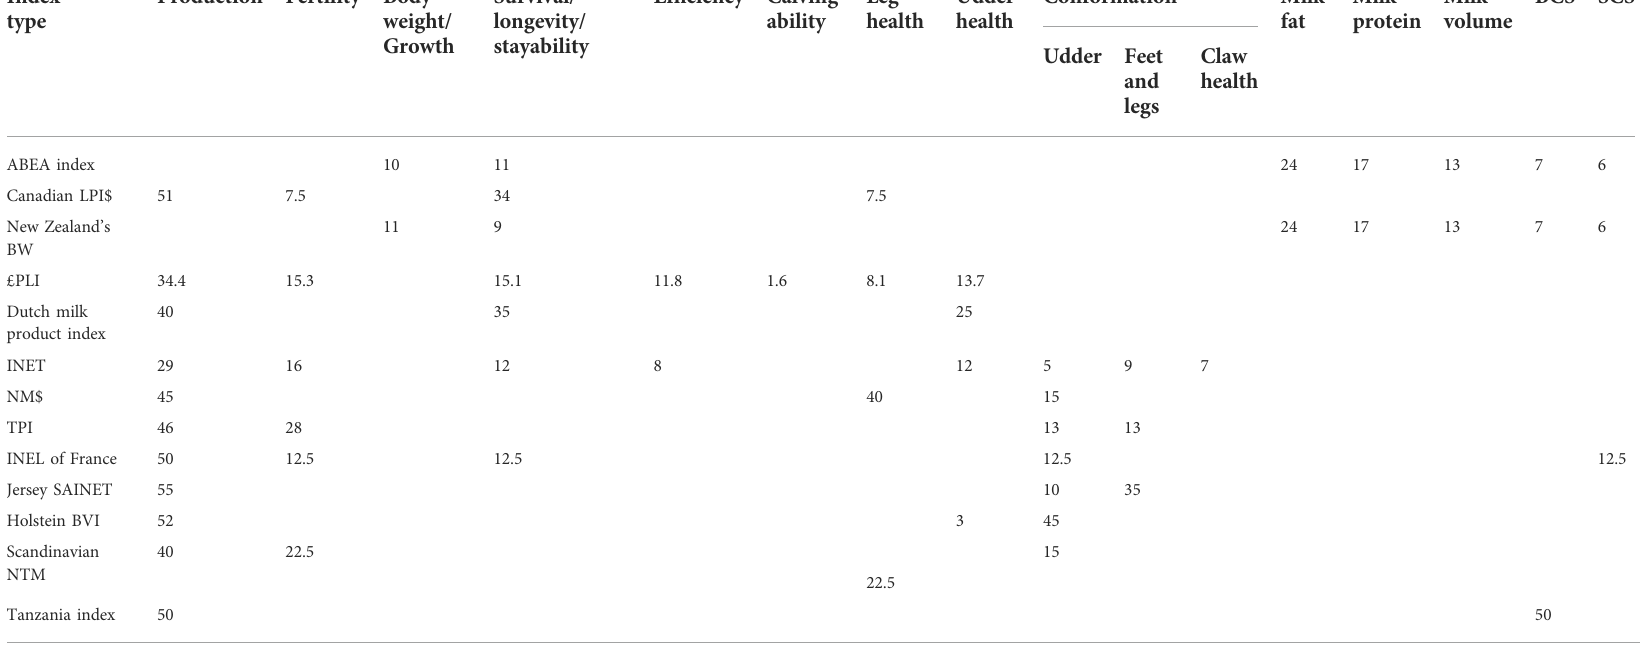
Production Fertility Body